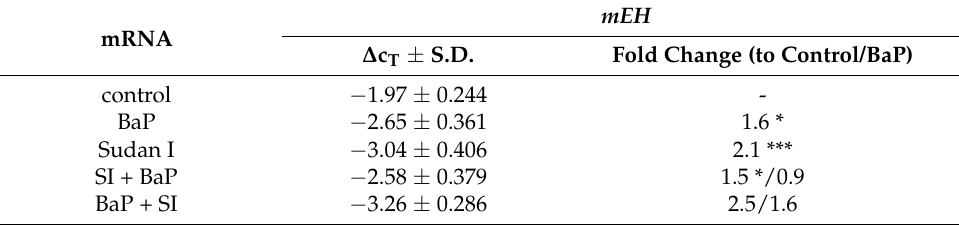
Table 2. Relative expression of mEH mRNA in livers from control (untreated) rats and rats exposed to BaP alone, Sudan I alone or Sudan I before BaP treatment (SI + BaP) or Sudan I after BaP treatment (BaP +